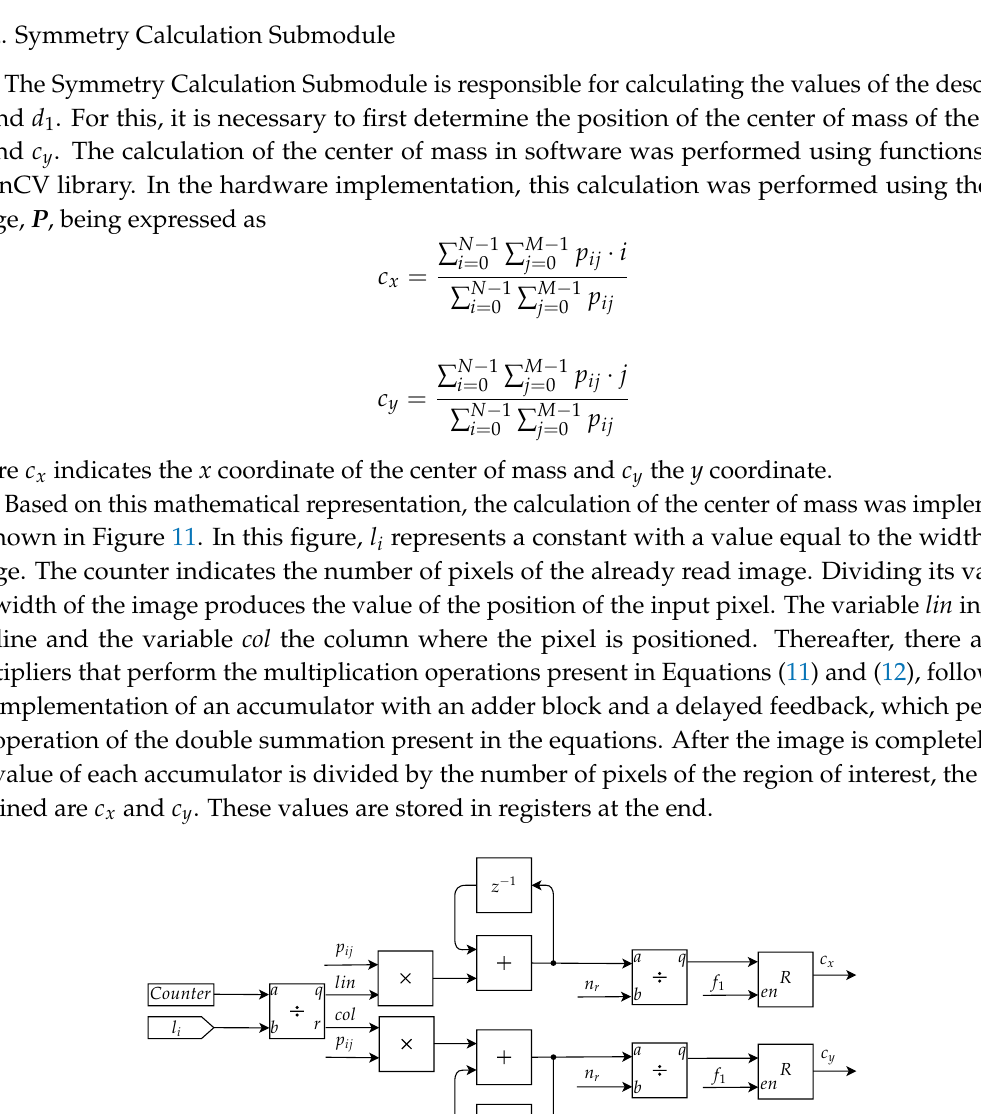
Figure 10. Architecture of the Mask Application Submodule.